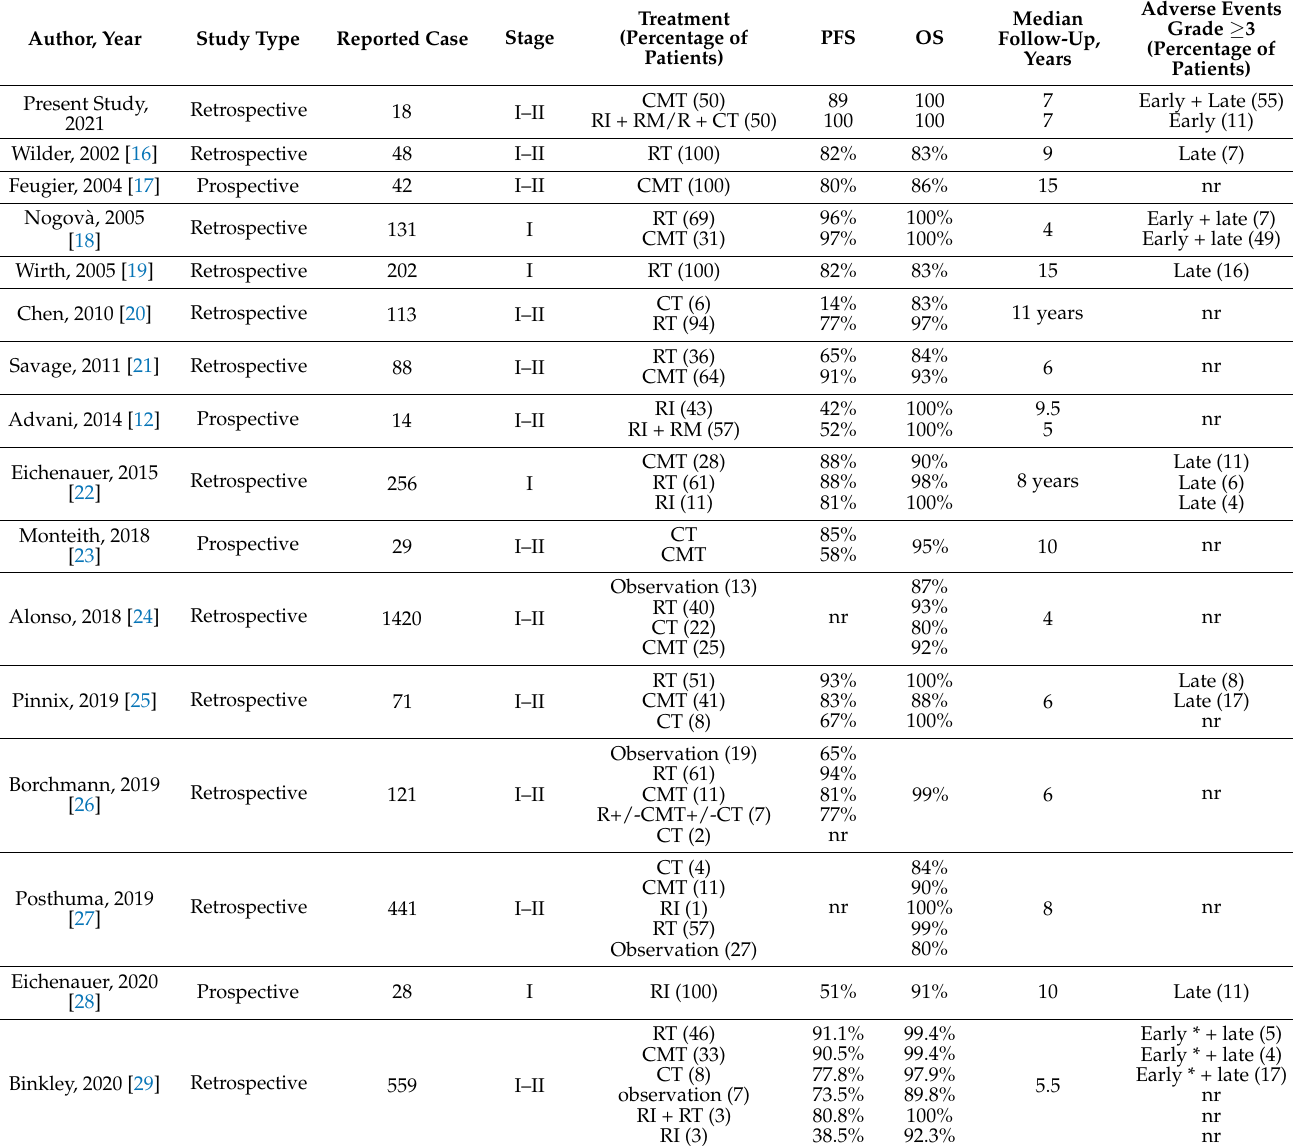
Outcomes from the principal studies reported in the setting of early stage and advance- stage NLPHLs are summarized in Tables 3 and 4. Table 3. Selected studies in early stage NLPHL, showing the relatively small number of patients treated with Rituximab- containing